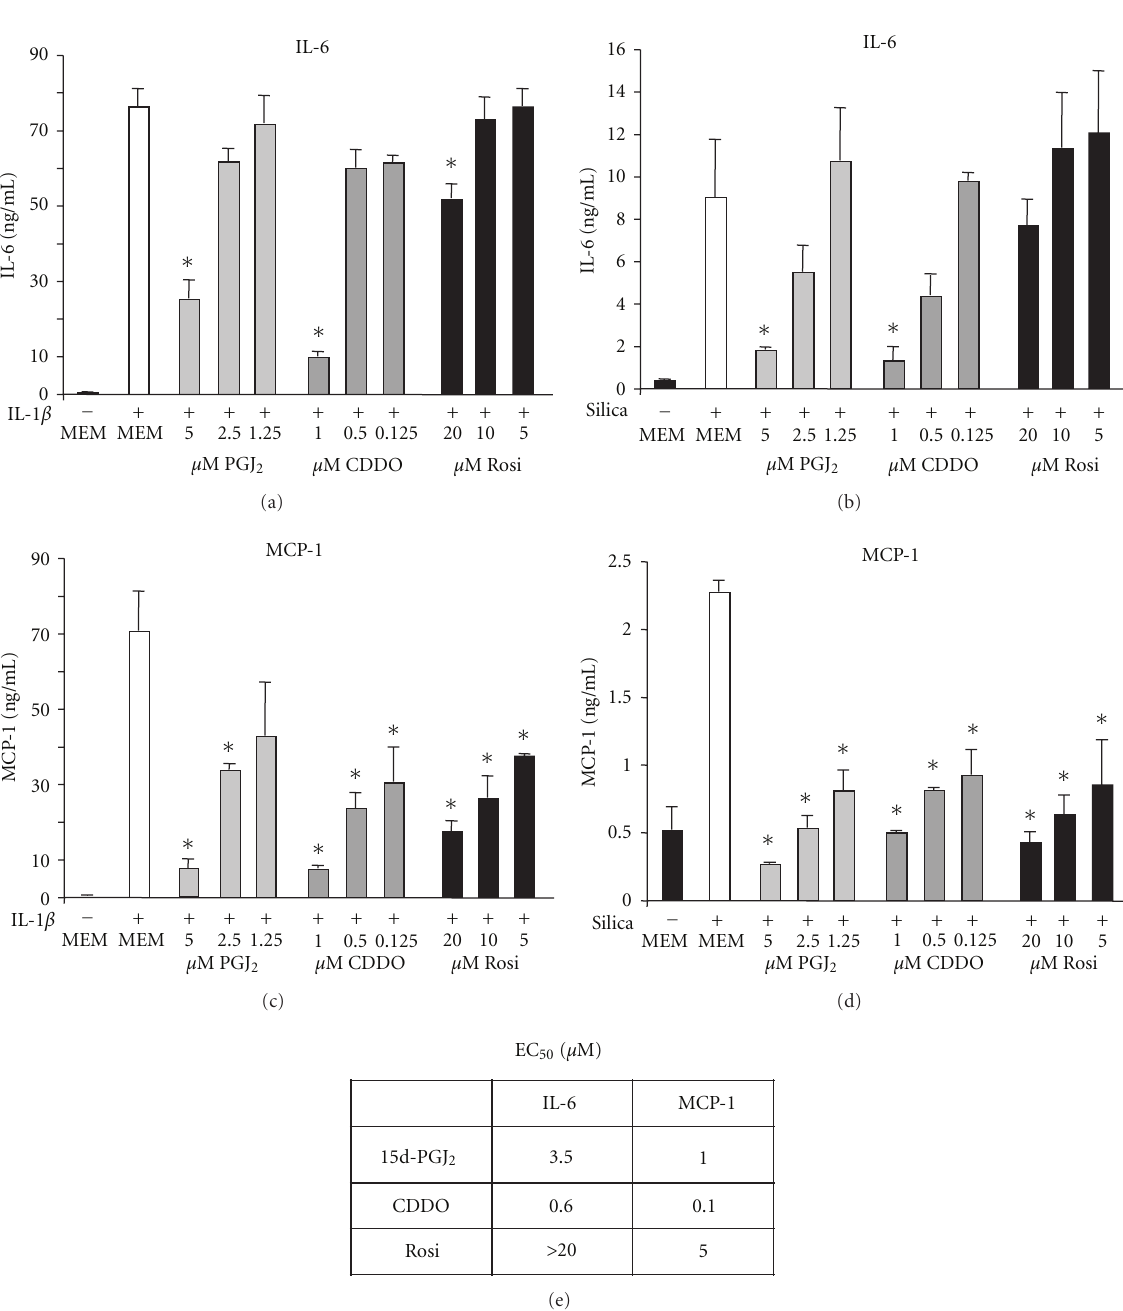
Figure 1: PPAR γ ligands attenuate IL-6 and MCP-1 production by human lung fibroblasts induced by IL-1 β or crystalline silica. Primary human lung fibroblasts were pretreated with the indicated concentrations of rosiglitazone (Rosi), CDDO or 15d-PGJ 2 (PGJ 2 ) for 1 hour and then cotreated with 1 ng/mL IL-1 β (a, b) or 10 μ g/mL crystalline silica (c, d) for 24 hours. Supernatants were harvested and cytokine concentrations were determined by ELISA. Results are mean ± standard error for quadruplicate wells and are representative of 2 independent experiments that yielded similar results. (e) The EC 50 was determined from the given data and averaged for each cytokine. Data were analyzed by one-way ANOVA. ∗ = P < . 05 compared to stimulus alone